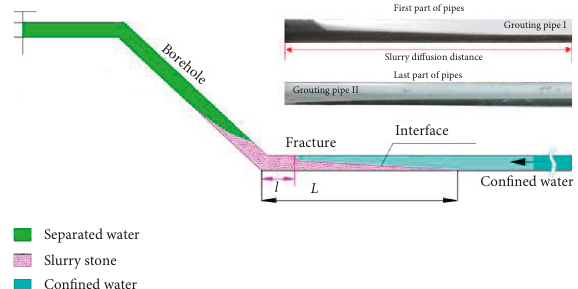
Figure 5: Slurry stone and water separation under the action of flowing water. The figure in the upper right corner is obtained in the experiment. L is the penetration distance, and l is the distance of the second deposition in the simulated fractures.